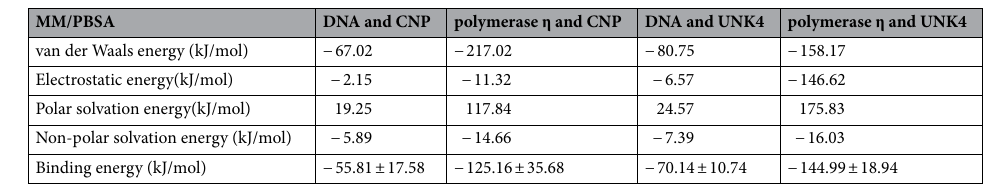
Table 3. Various energy terms obtained through MM/PBSA